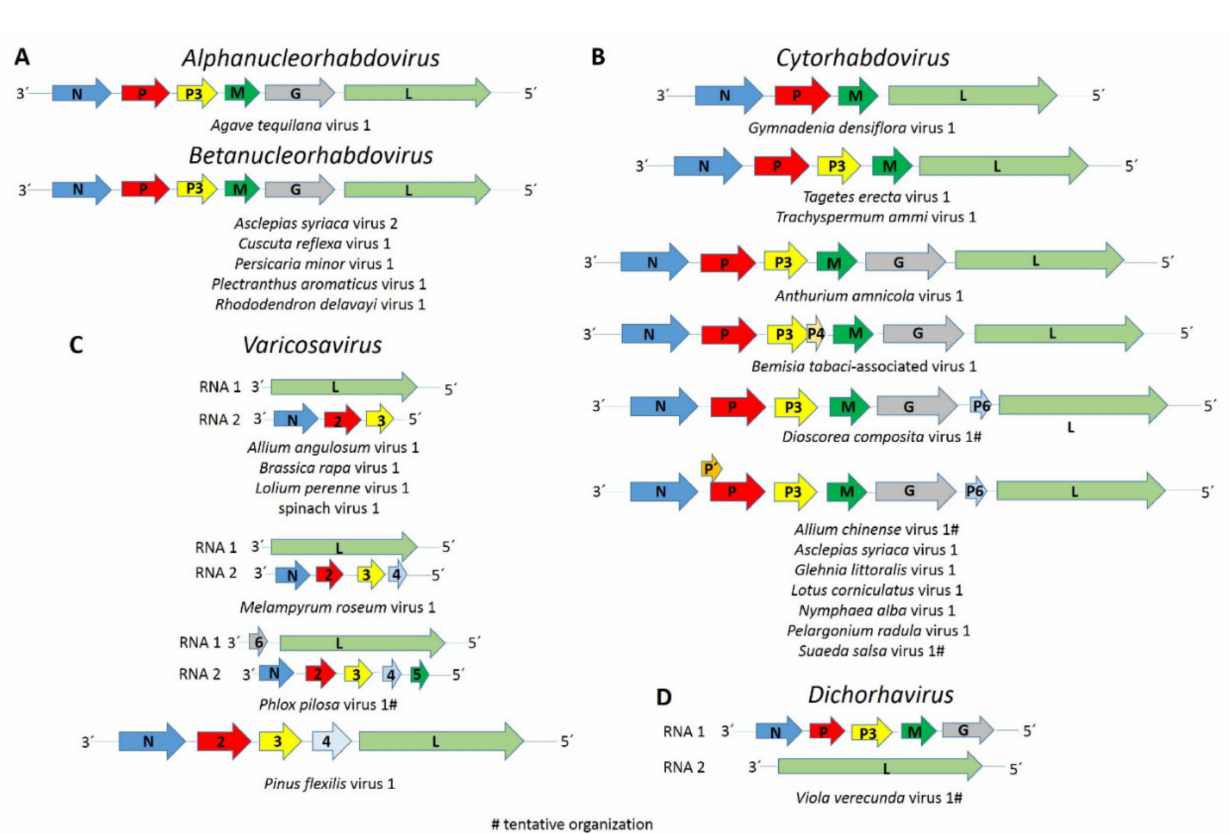
Table 3. Pairwise identity percentages between ATV1 and the selected alphanucleorhabdoviruses. Genome a